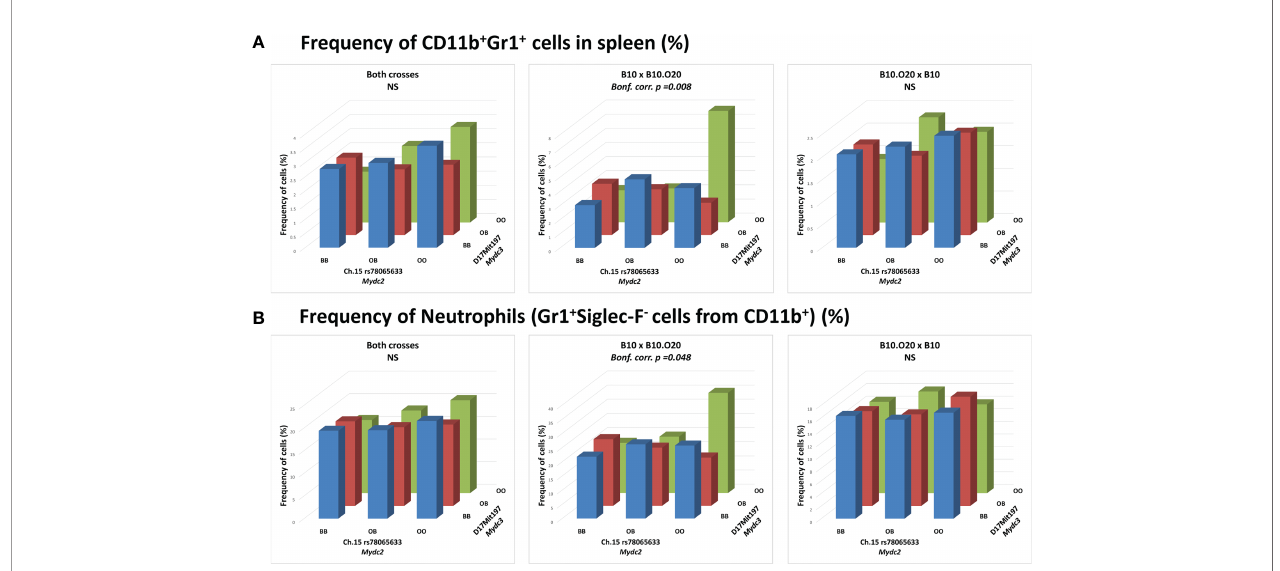
FIGURE 5 | Interaction between loci Mydc2 and Mydc3 in control of myeloid-derived cells. Bars indicate the average frequency of (A) CD11b + Gr1 + cells or (B) neutrophils (Gr1 + Siglec-F - cells from CD11b + cells) for the indicated cross and genotype. p- values were calculated by analysis of variance (ANOVA). O and B indicate the presence of O20 and B10 allele, respectively. NS, Not signi fi